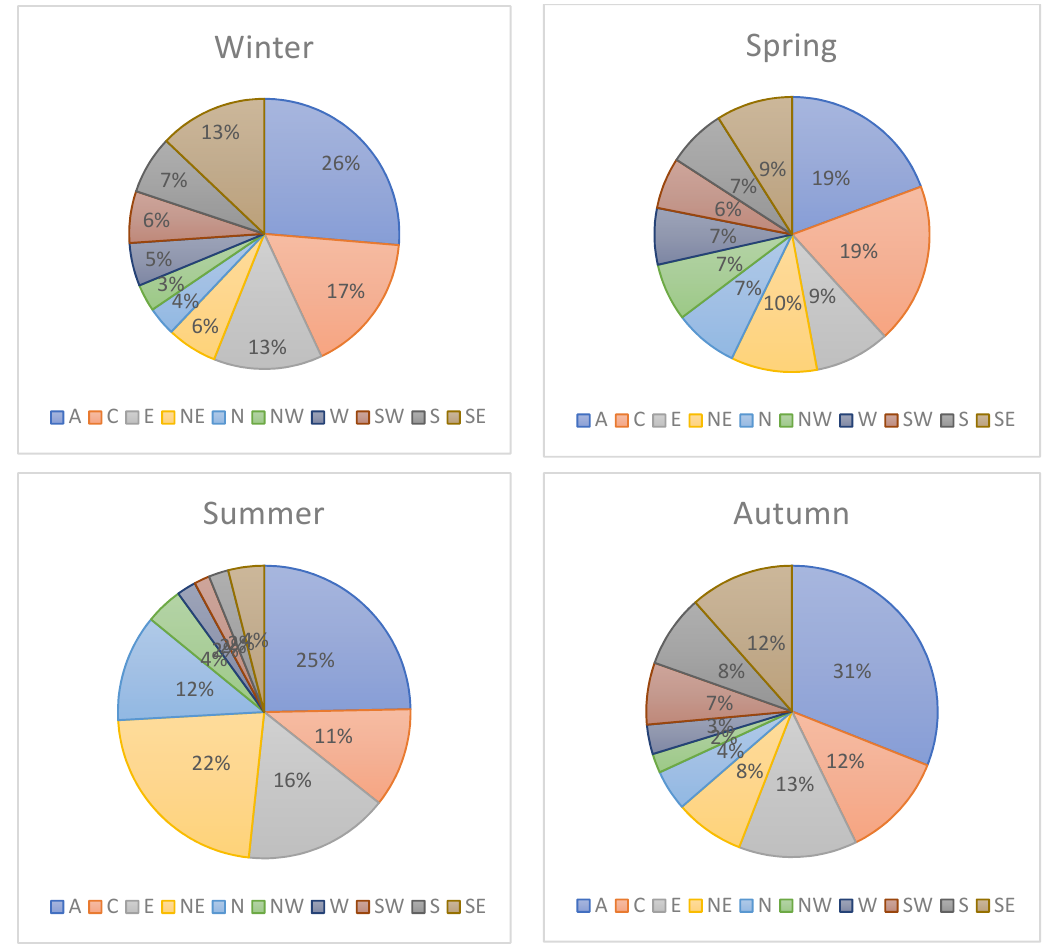
Figure 3. Frequency of circulation weather types per season during the period 1949–2018: A—anticyclonic; C—cyclonic; E—eastern, NE—northeastern, N—northern, NW—northwestern, W—western, SW—southwestern, S—southern and SE—southeastern.